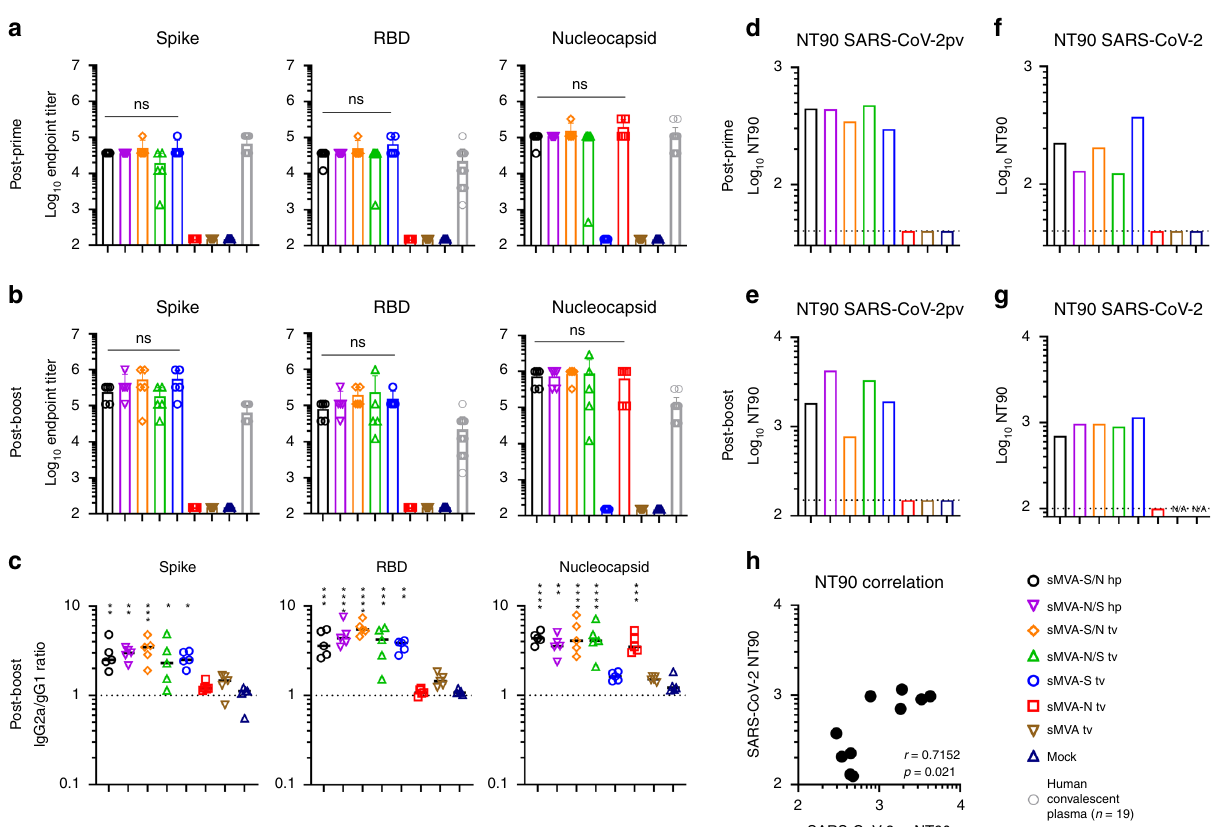
Fig. 5 Humoral immune responses stimulated by sMVA-CoV2 vectors. Balb/c mice ( n = 5) immunized twice in a 3-week interval with 5 × 10 7 PFU of the single and double recombinant sMVA-CoV2 vectors derived with FPV HP1.441 (sMVA-S/N hp and sMVA-N/S hp) or TROVAC (sMVA-S/N tv, sMVA-N/ S tv, sMVA-S tv, sMVA-N tv) were evaluated for SARS-CoV-2-speci fi c humoral immune responses. a , b Binding antibodies. S-, RBD-, and N-speci fi c binding antibodies induced by the vaccine vectors were evaluated after the fi rst ( a ) and second ( b ) immunization by ELISA. As a comparison, antigen- speci fi c endpoint titers measured in n = 19 plasma samples from SARS-CoV-2 convalescent individuals (Fig. S4) were added in a and b . Data are presented as mean values + SD. One-way ANOVA with Tukey ’ s multiple comparison test was used to evaluate the differences between binding antibody end-point titers. c IgG2a/IgG1 isotype ratio. S-, RBD-, and N-speci fi c binding antibodies of the IgG2a and IgG1 isotype were measured after the second immunization using 1:10,000 serum dilution, and absorbance reading was used to calculate IgG2a/IgG1 antibody ratio. Lines represent median values. One-way ANOVA with Dunnett ’ s multiple comparison test was used to compare each group mean IgG2a/IgG1 ratio to a ratio of 1 (balanced Th1/Th2 response). d – g NAb responses. SARS-CoV-2-speci fi c NAb (NT90 titer) induced by the vaccine vectors were measured after the fi rst ( d , f ) and second ( e , g ) immunization against SARS-CoV-2 pseudovirus (pv) ( d , e ) or infectious SARS-CoV-2 virus ( f , g ) in pooled sera of immunized mice. Shown is the average NT90 measured in duplicate ( d , e ) or triplicate ( f , g ) infection. N/A = failed quality control of the samples. Dotted lines indicate lowest antibody dilution